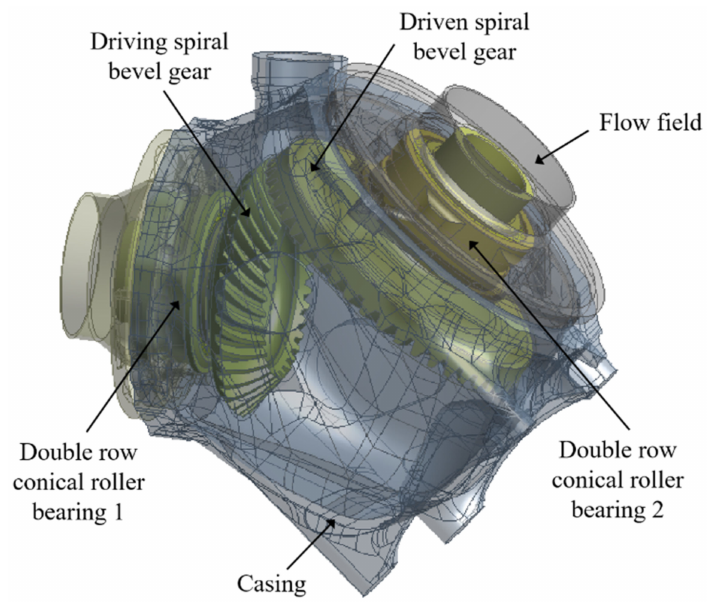
Figure 6. Computational model.